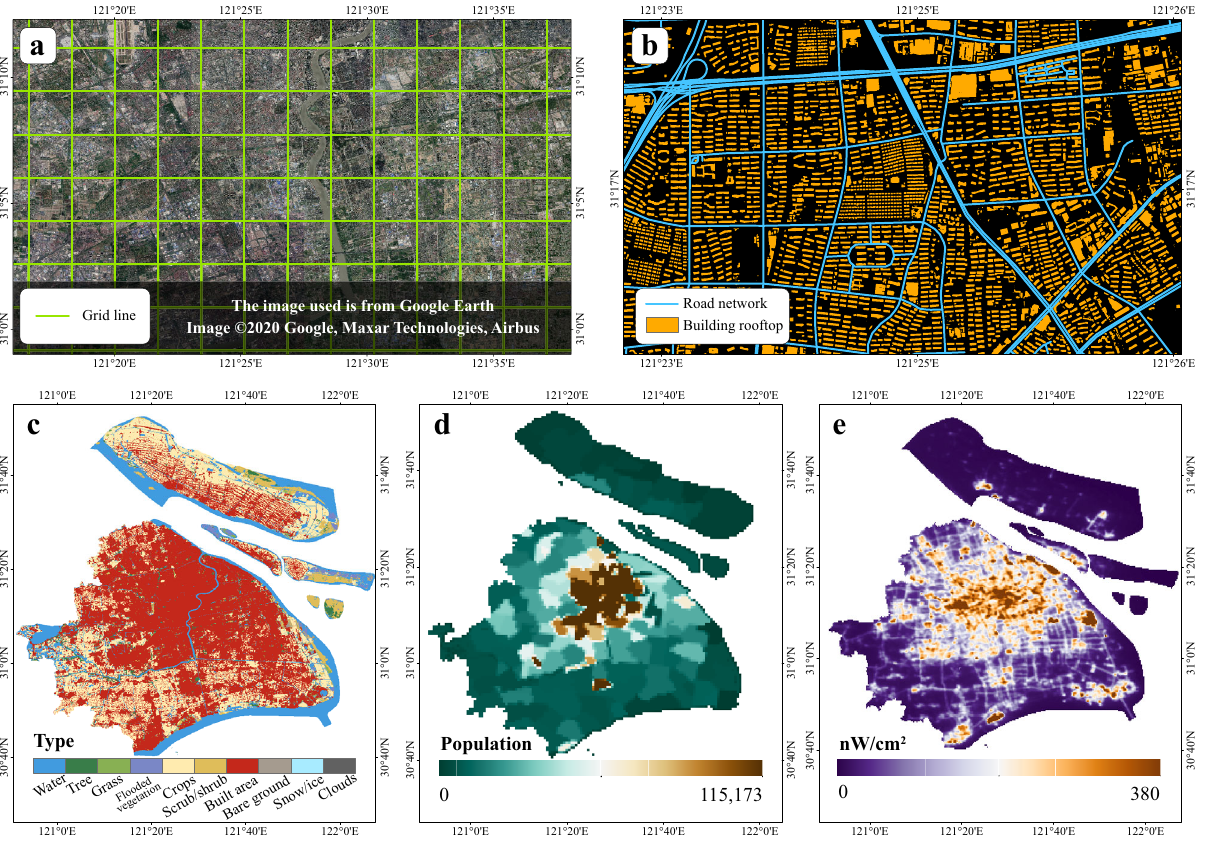
Fig. 2 | Visual representation of the data involved in the regression analysis. a Green lines divide the basic cells of the extrapolation. b Orange polygons represent the vectorized rooftop area, and blue lines represent the major road networks. Considering Shanghai as an example, c land cover with the built area colored in red indicates the potential building distribution; d population size with